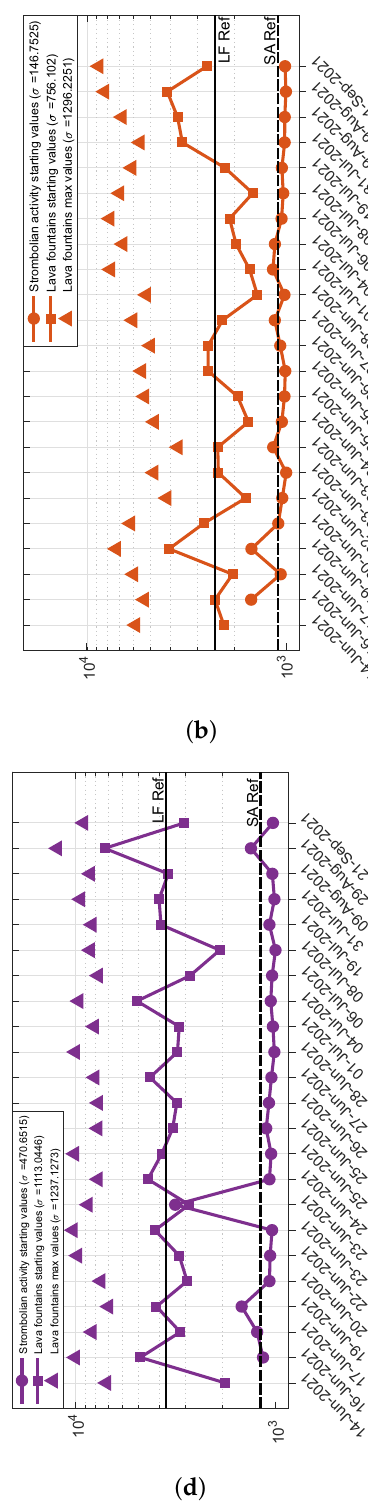
Figure 4. Starting values related to each of the 23 considered eruptive episodes for the Strombolian activity (circles) and lava fountains (squares) and max values (triangles) for the paroxysmal phase of the lava fountains for RB1 ( a ), RB2 ( b ), RB3 ( c ), RB4 ( d ). Within all panels, the reference values for the Strombolian activity ( SA Ref , dashed line) and lava fountains ( LF Ref , solid line) are shown (see Table 3); such reference values were obtained by averaging the starting values for both activities and each episode. The standard deviations for each RB and volcanic phenomenon are also